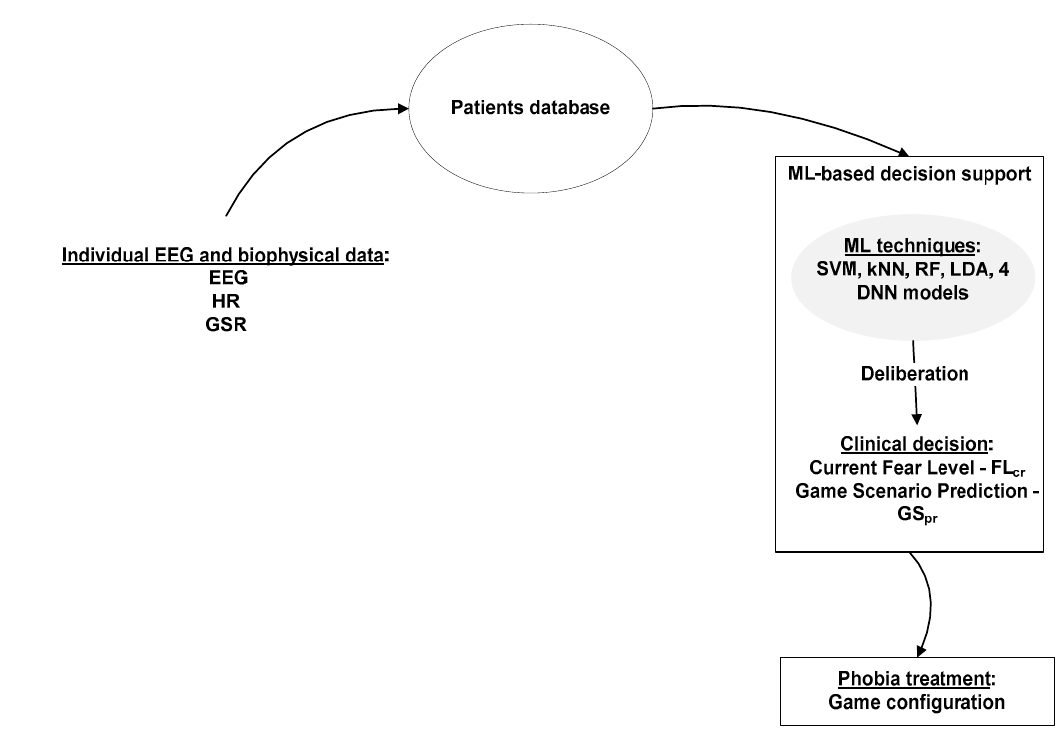
Figure 1. ML-based decision support for phobia